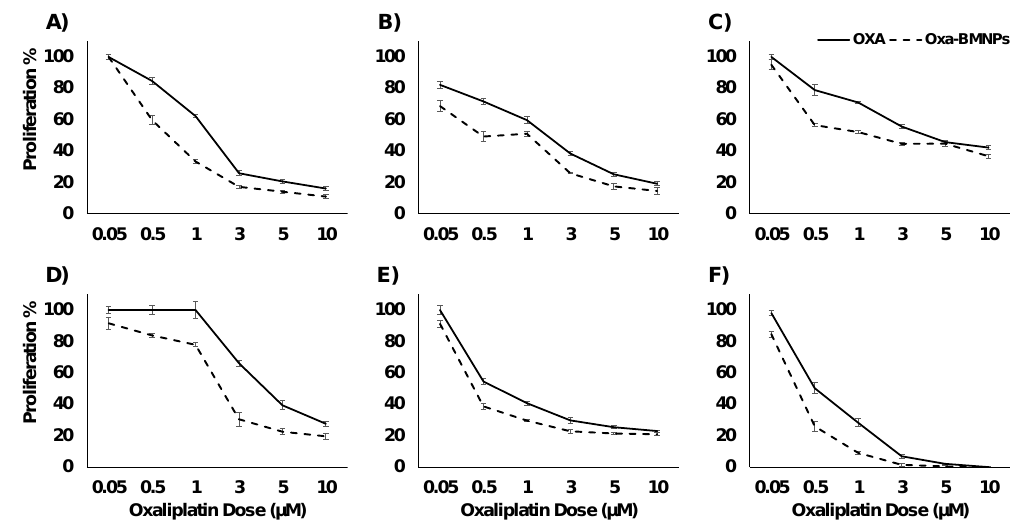
Figure 3. Cell proliferation assay of colon (tumor and non-tumor) cell lines treated with soluble Oxa and Oxa–BMNP. The percentages of proliferation of HT29 ( A ), SW480 ( B ), HCT15 ( C ), MC38 ( D ), T84 ( E ), and CCD18 ( F ) cell lines obtained using the sulforhodamine B (SRB) assay are shown. Data